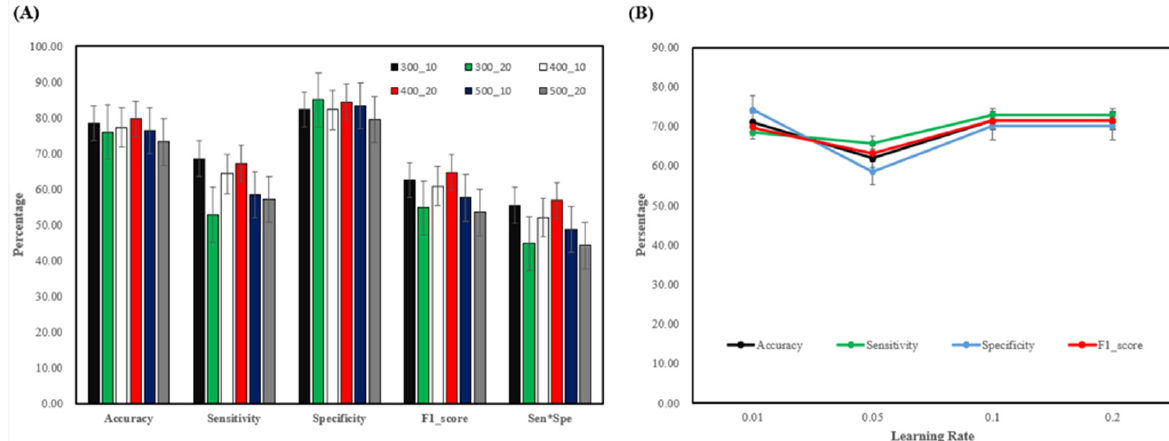
Figure 4. ( A ) The first number (300, 400, 500) represents the n_estimators and the second number represents the max_depth (10, 20). Analysis of this cross pair shows that the most stable performance is when the hyperparameter value is 400_20 ( B ) The learning rate is the lowest at 0.05 and 0.1, 0.2 are more stable.